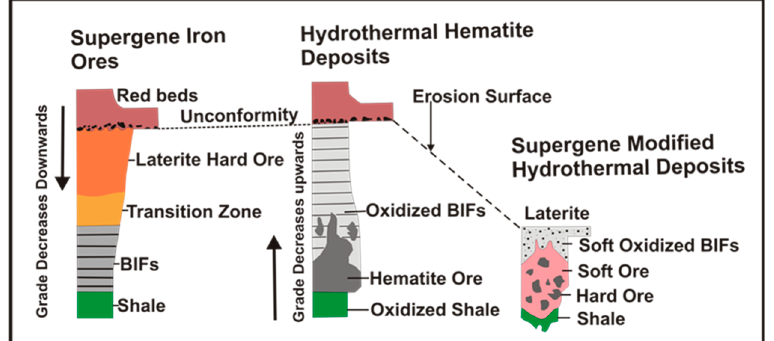
Figure 14. Schematic diagram showing supergene-modified hydrothermal process for the formation of different types of iron ores at Kiriburu-Meghahatuburu region from the BIFs modified after [32].